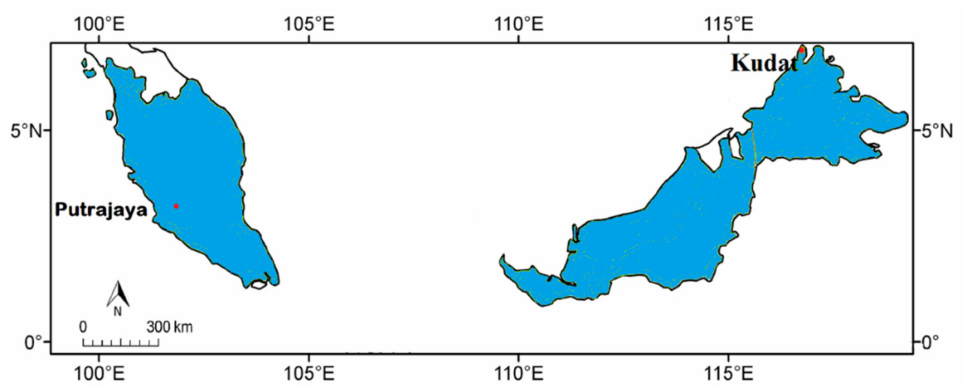
Figure 4. Map of Malaysia with the selected